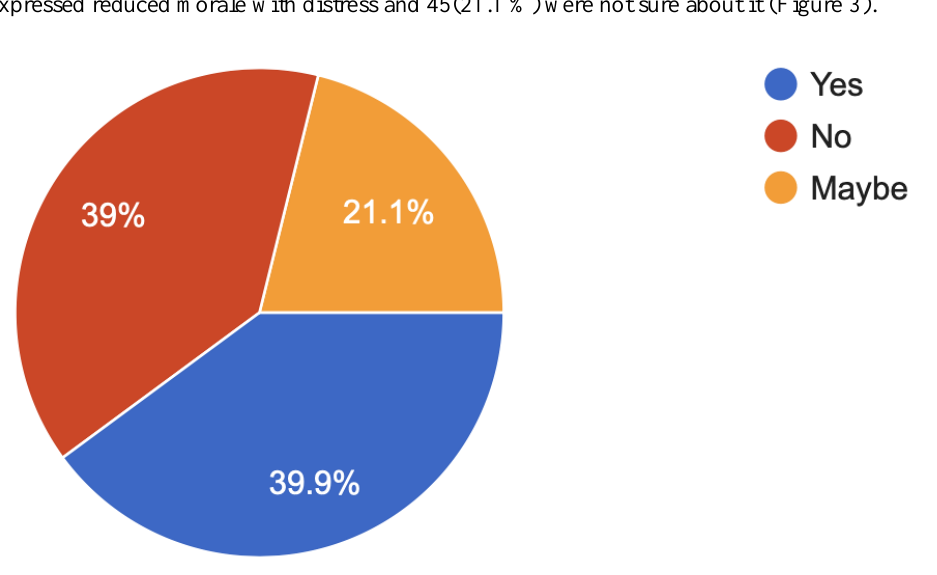
Figure 3. Work pattern leading to distress and reduced morale (n= 213)